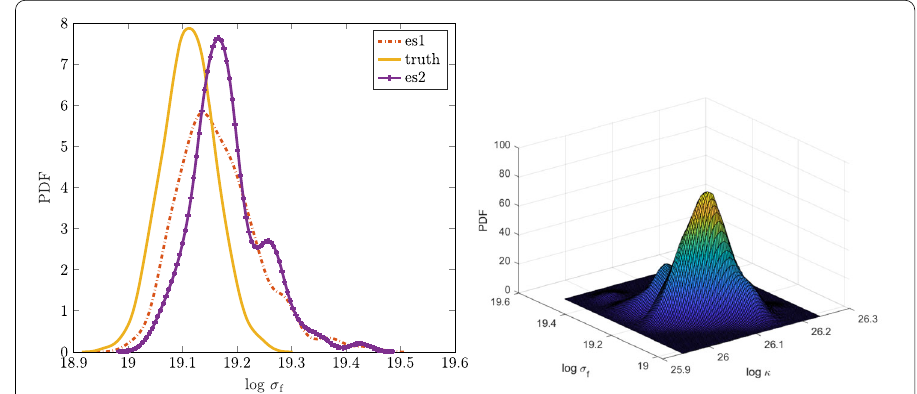
Fig. 14 Left: Comparison of two up-scaling strategies described by Eqs. (43) and (44) in terms of PDF of the log of macro-scale parameters, Right: Correlation between the log of macro-scale parameters